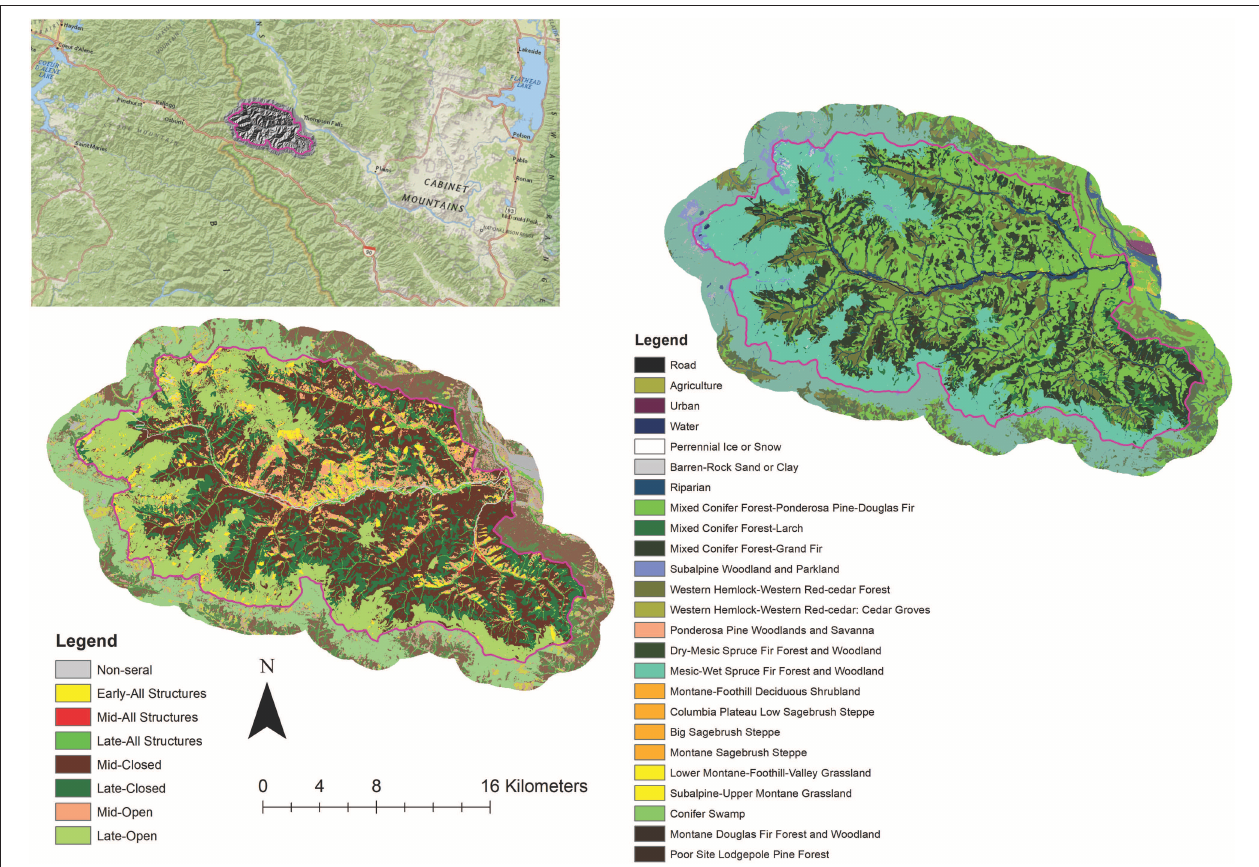
FIGURE 3 | Prospect Creek sub-landscape. The panel in upper left of figure shows the location of the Prospect Creek watershed. The panel in the lower left shows the seral stage mosaic of the watershed, while the panel in the upper right shows the vegetation cover type mosaic of the watershed.